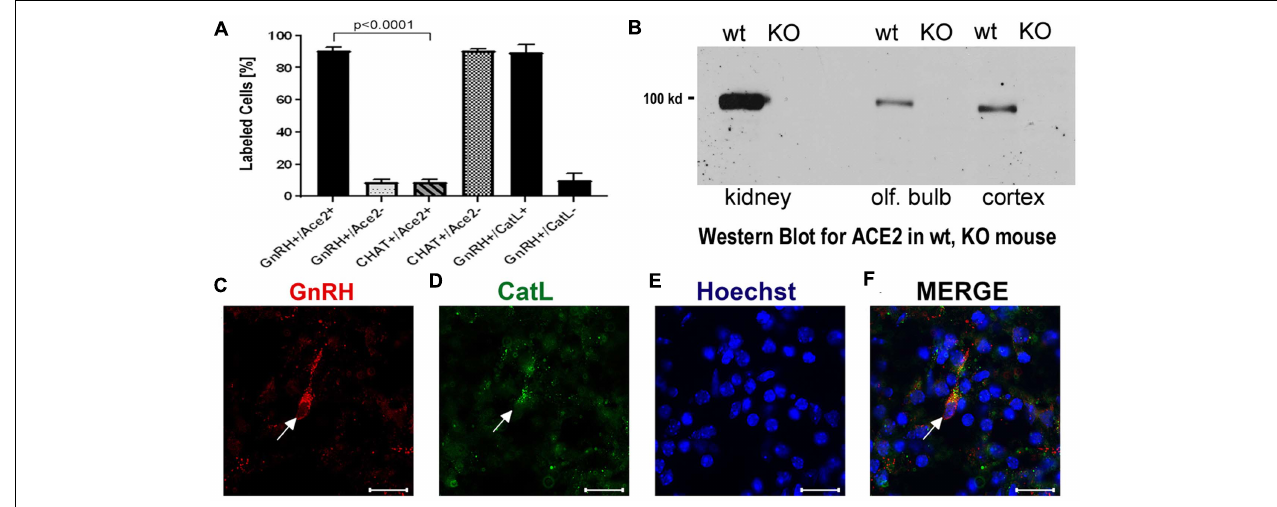
FIGURE 3 | (A–F) Quantification of neurons labeled with nervus terminalis markers, virus entry proteins, and verification of the specificity of the ACE2 antibody. (A) The large majority of GnRH-positive neurons is also ACE2-positive. In contrast, the majority of CHAT-positive (cholinergic) nervus terminalis neurons lack ACE2-expression. The total number of counted GnRH-positive or CHAT-positive neurons was set at 100%. Error bars represent ± SEM. A t -test shows that the colocalization difference between GnRH- and CHAT-positive nervus terminalis neurons is significant at p < 0.0001. For further details, see Supplementary Table 2 . (B) Western blot of ACE2 in wildtype (wt) mice and in ACE2 knock-out (KO) mice. The first two lanes (kidney) were loaded with 25 µ g total protein, the lanes for olfactory bulb and cerebral cortex were loaded with 60 µ g total protein, and probed with the R&D ACE2 antibody. No ACE2 protein was detectable in the ACE2 KO mice, proving that the antibody indeed recognizes ACE2. (C–F) Example of GnRH-positive nervus terminalis neurons which are also cathepsin L-positive. (C) One GnRH-labeled neuron is marked with a white arrow. (D) The same neuron is labeled with the cathepsin L antibody (CatL, white arrow). (E) The cell nuclei are stained with Hoechst nuclear dye. (F) The three images are merged to show co-localization in the neuron indicated with the white arrow. All scale bars are 20 µ